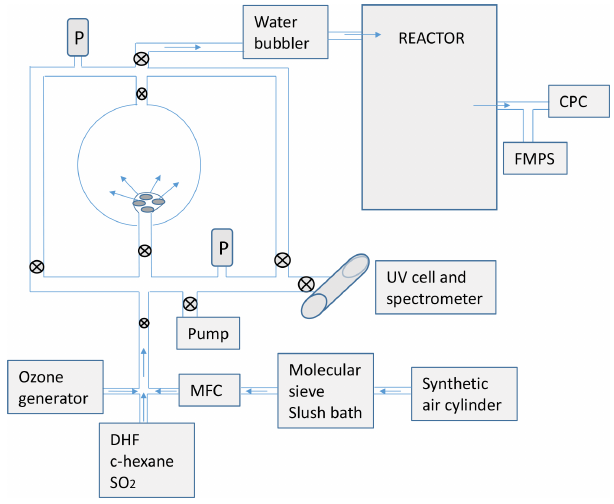
Figure 1. Schematic set-up of the experimental